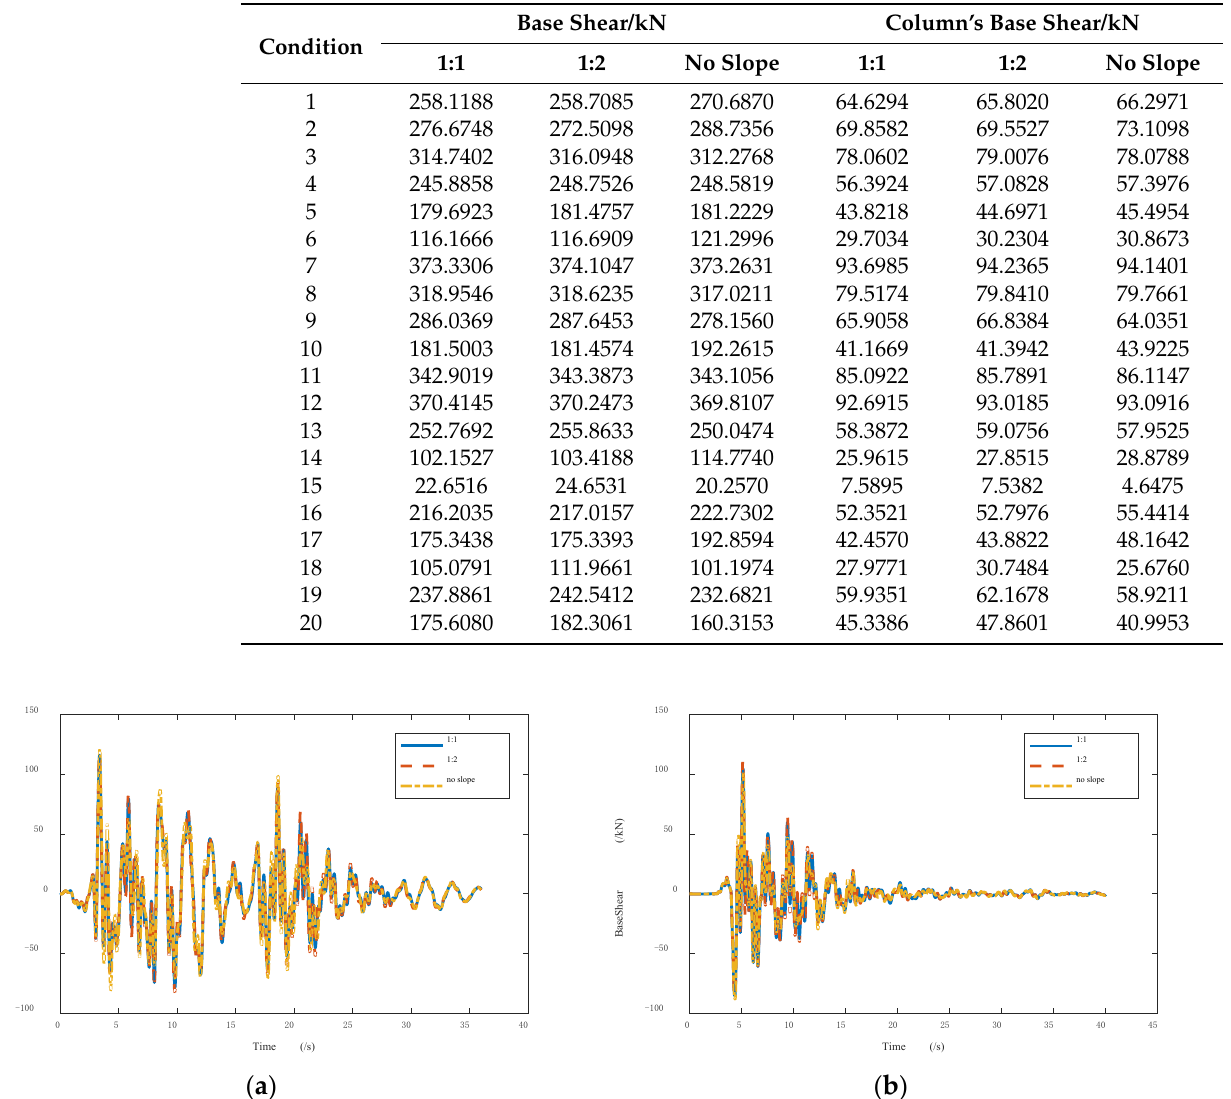
Figure 12. Time history curve of base shear: ( a ) working condition 6; ( b ) working condition 18.